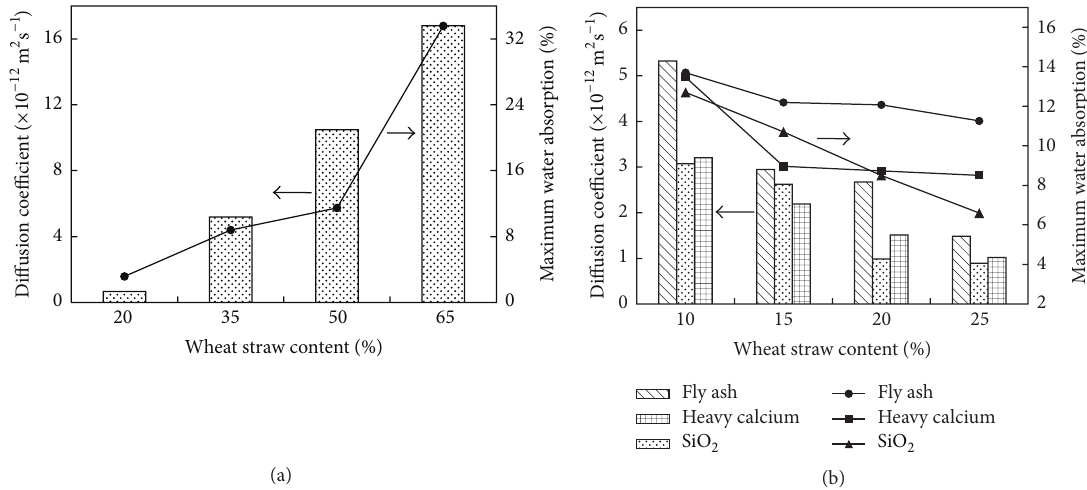
Figure 6: Water diffusion coefficients and maximum water absorption of WS filled PP composites (a) and WS and inorganic filler reinforced PP composites